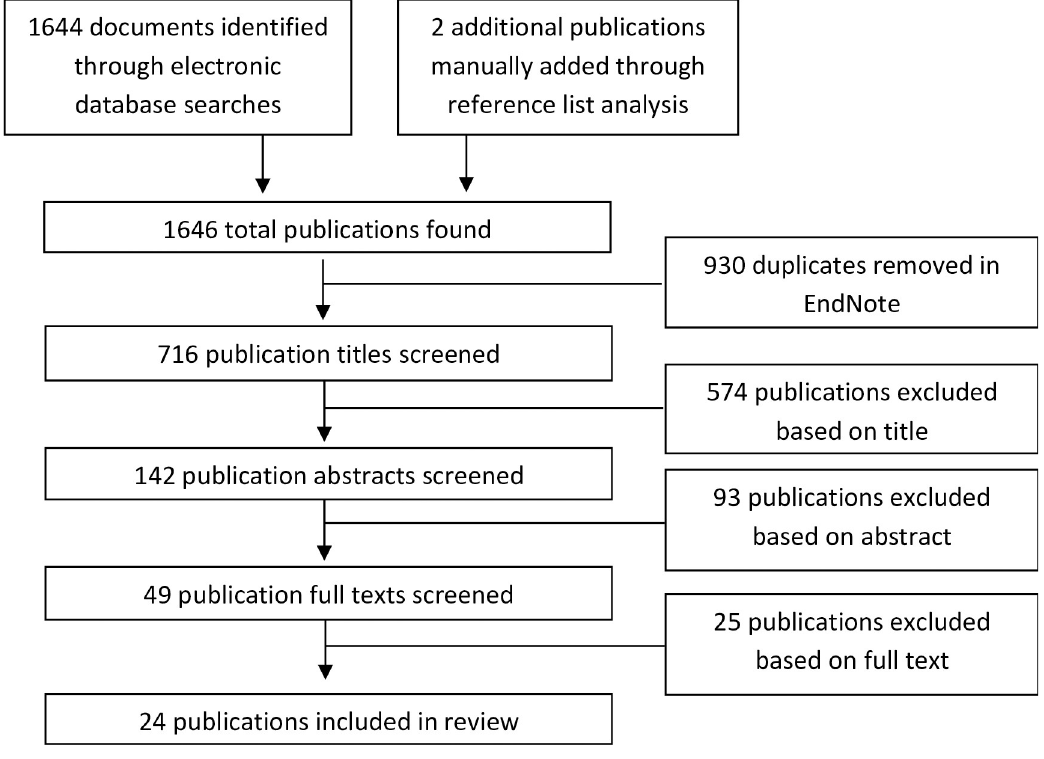
Fig 1. Flow chart of the selection